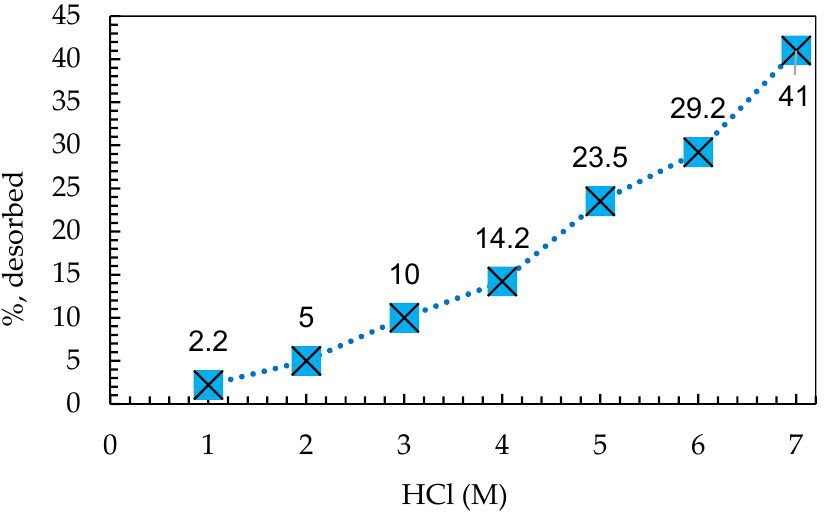
Figure 6. Influence of acidic medium for AB 113 dye desorption of loaded resin. The values presented are mean of three replicates with RSD% below 8% for all experiments.